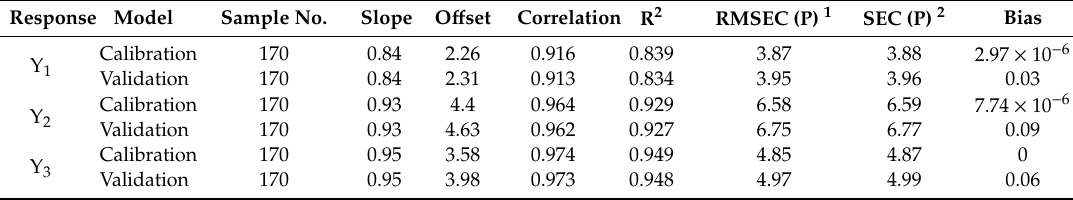
Table 2. Statistical parameters of partial least square models.